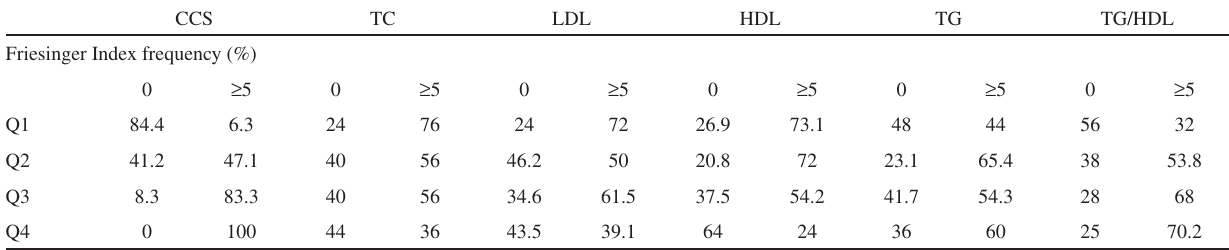
Table 4 - Frequency of extensive coronary disease (Friesinger index ≥ 5) by quartiles of coronary calcium score and lipid variables